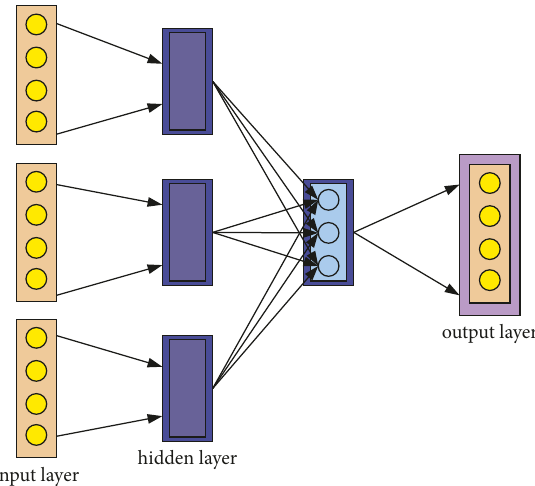
Figure 3: Skip-gram model.